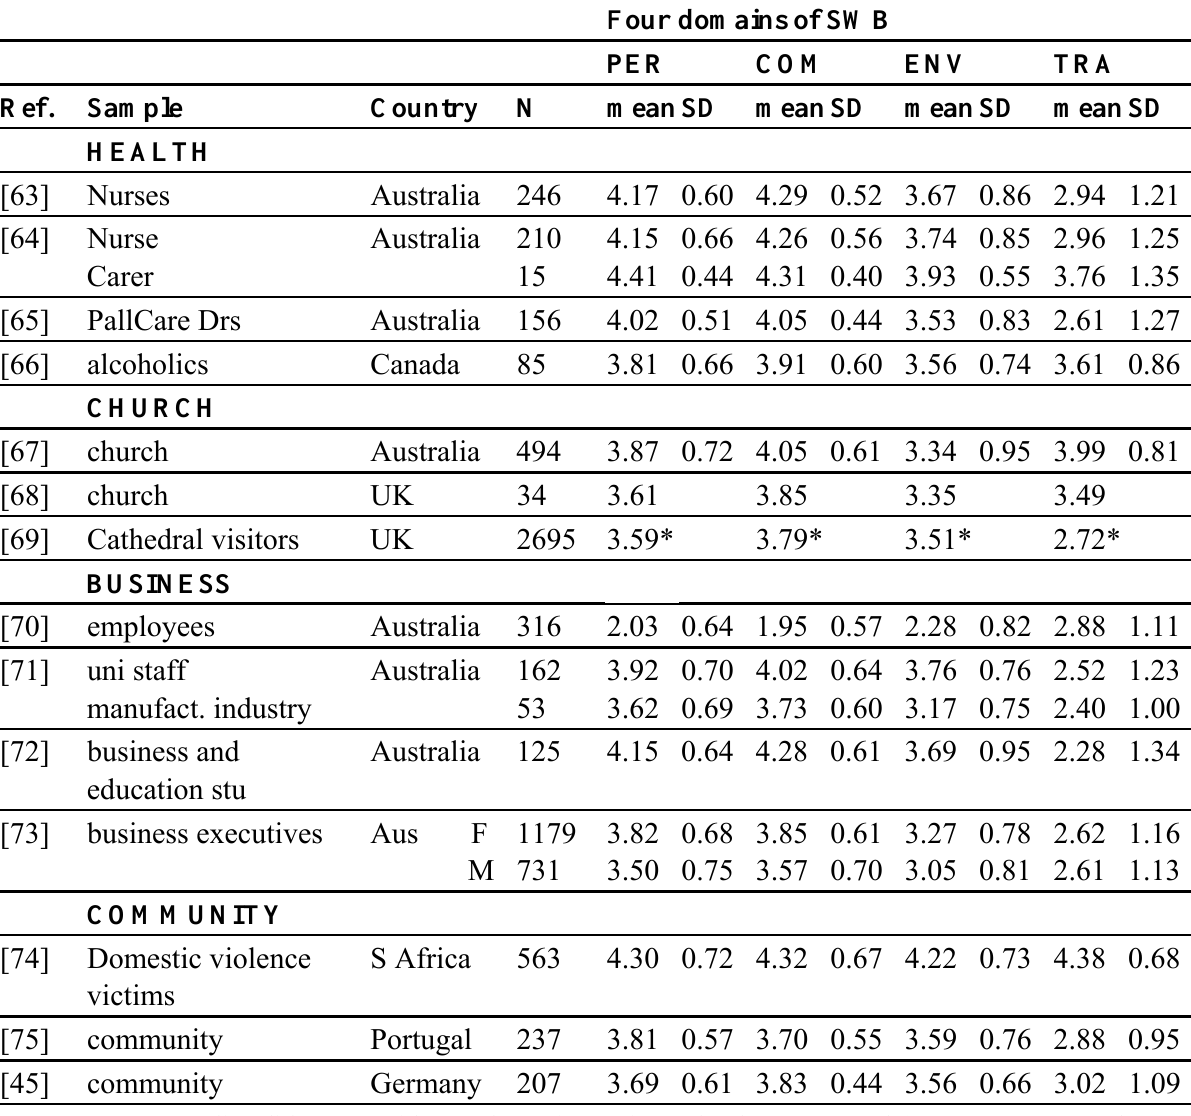
Table 4. SWB levels in health care, Churches, business and community using the